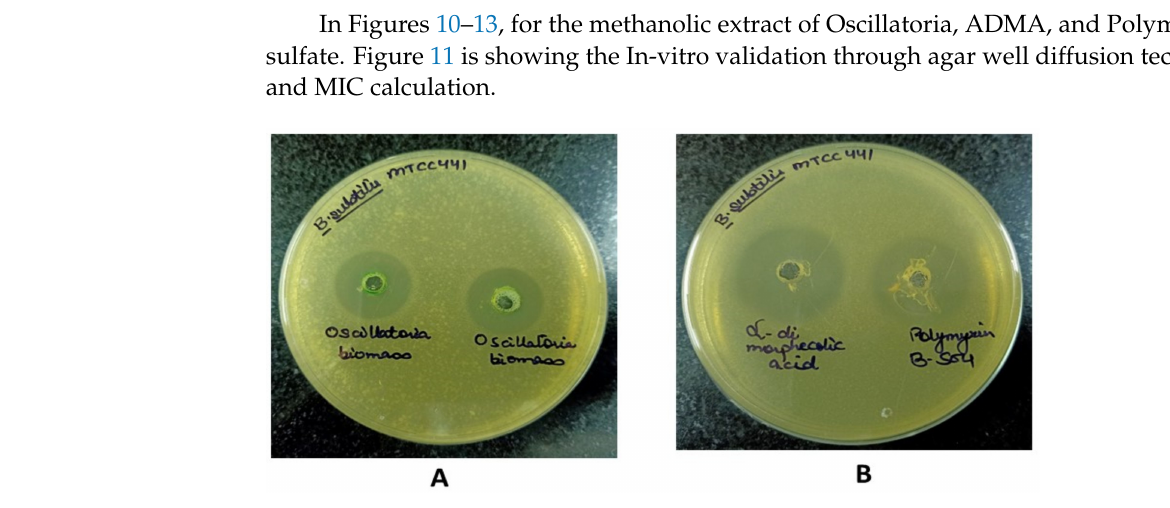
Figure 10. Zone of inhibition against Bacillus subtilis (MTCC 441): Muller Hinton Agar plate, ( A ) well size: 16.14 mm for Methanolic extract of Oscillatoria biomass (100 µ gmL − 1 ). ( B ) 23.12 mm for Alpha dimorphecolic acid (5 µ gmL − 1 ) 21.33 mm for Polymyxin B-sulphate (5 µ gmL − 1 ). Zone size in mm